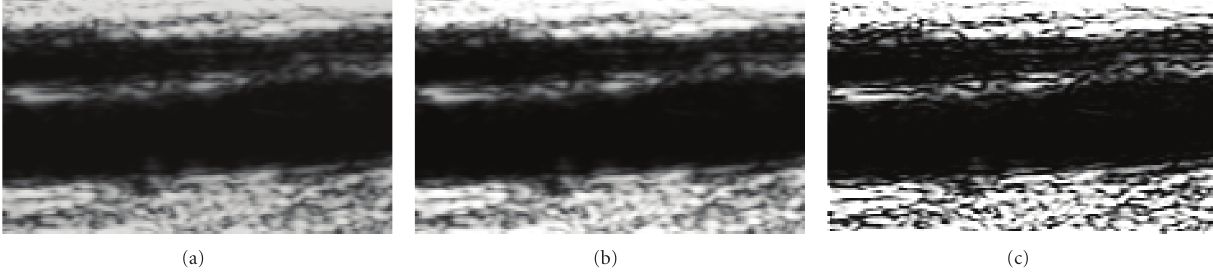
Figure 2: Preprocessing. (a) Original image; (b) after histogram stretching; (c) after